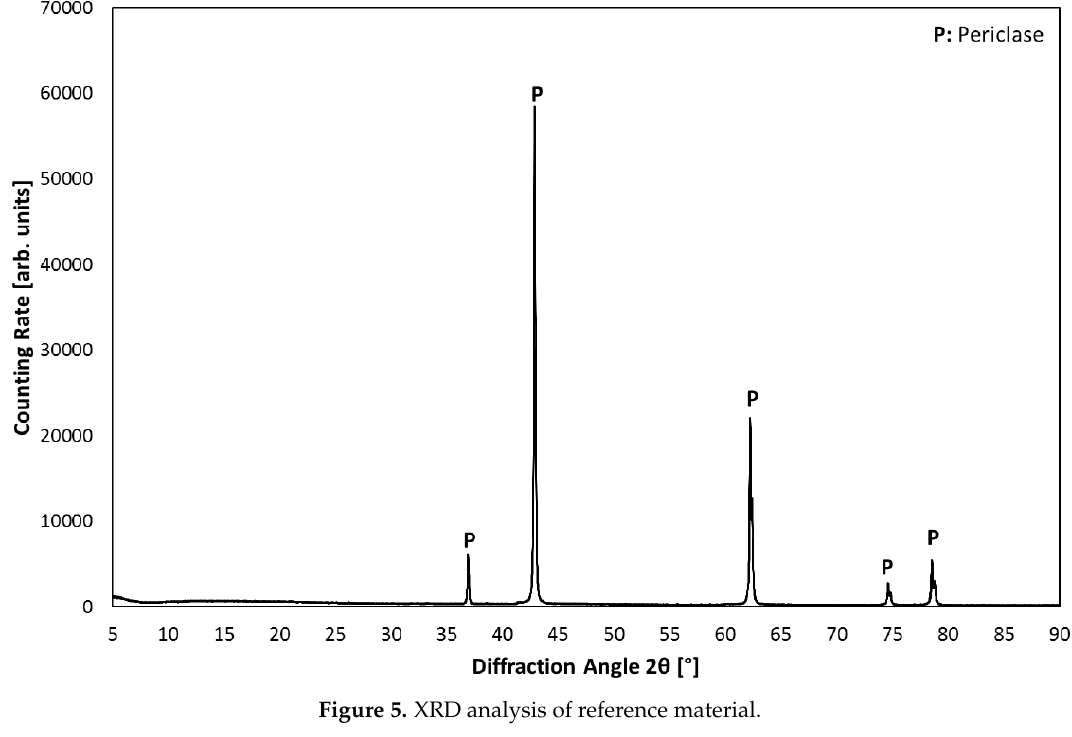
Metals 2018 , 8 , x FOR PEER REVIEW Figure 5. XRD analysis of reference material. Figure 5. XRD analysis of reference material.